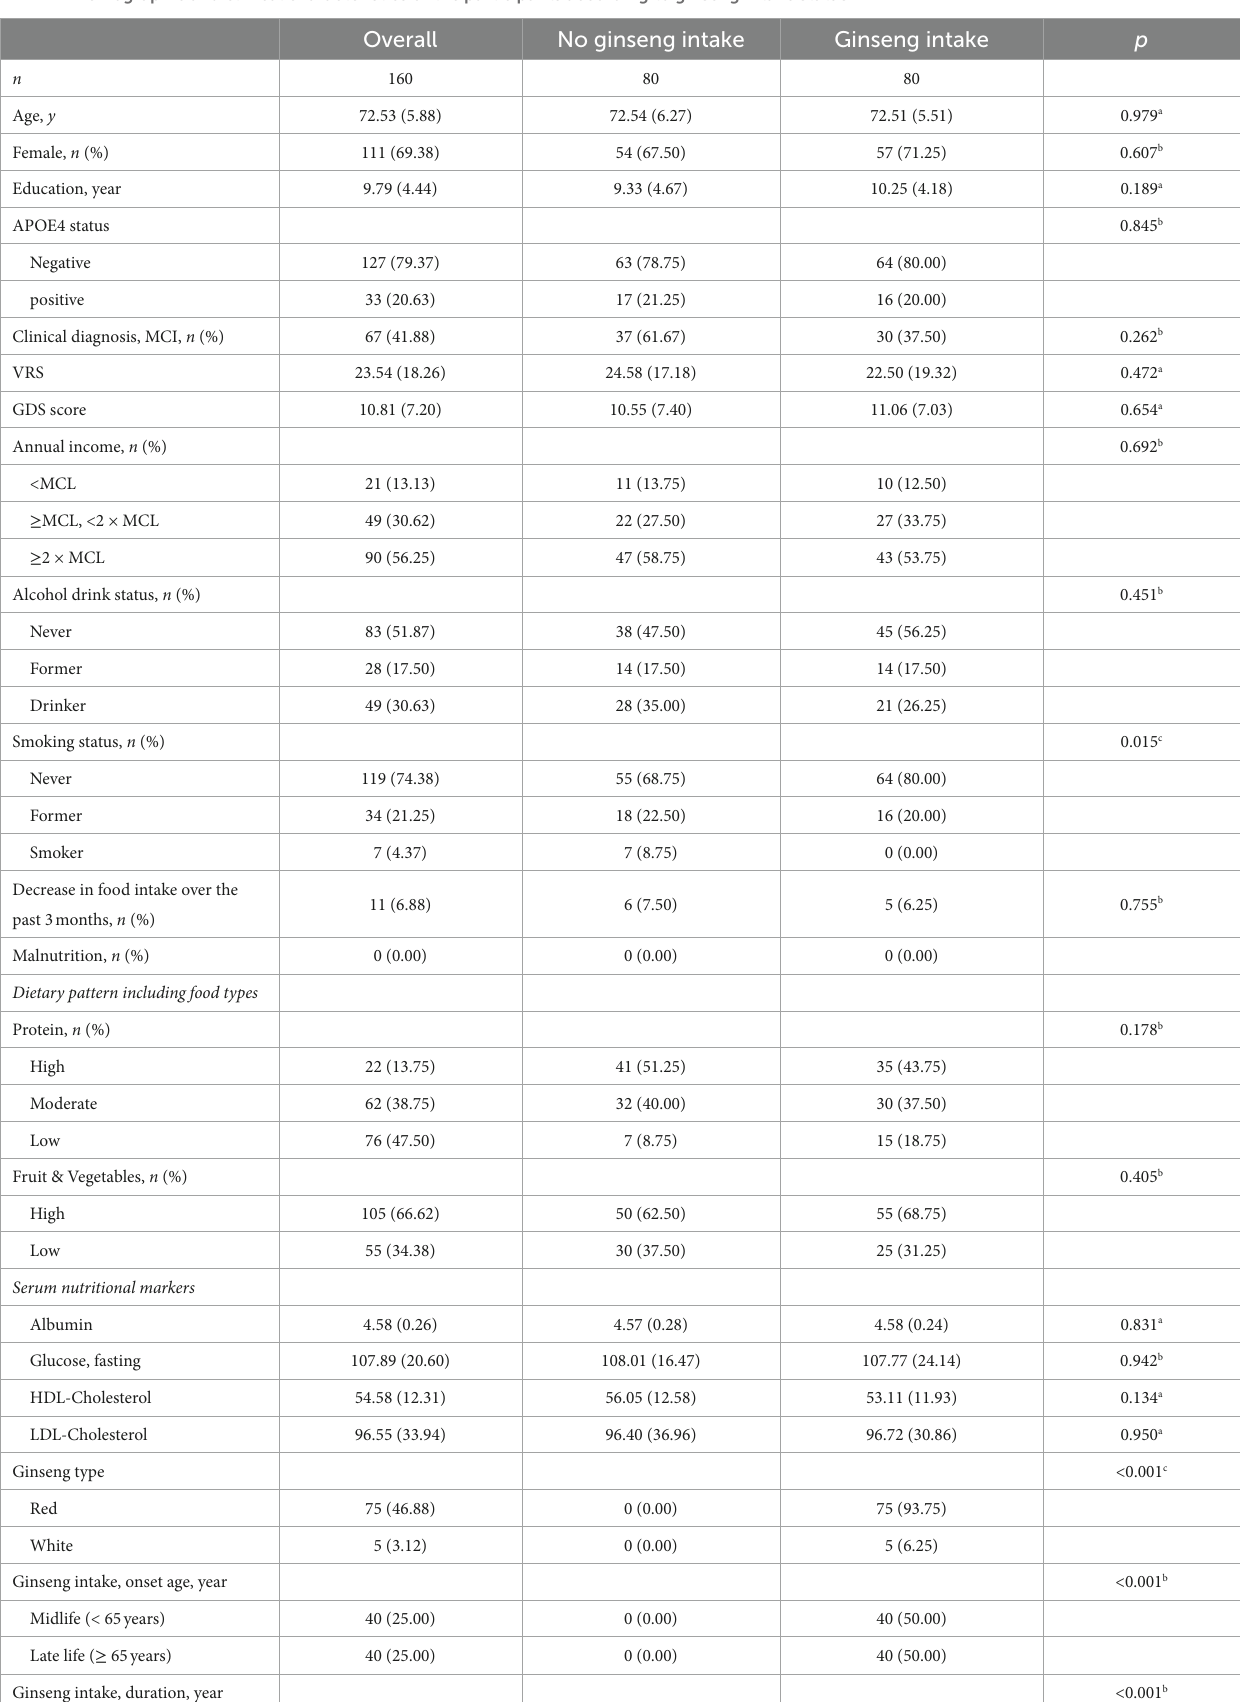
TABLE 1 Demographic and clinical characteristics of the participants according to ginseng intake status.